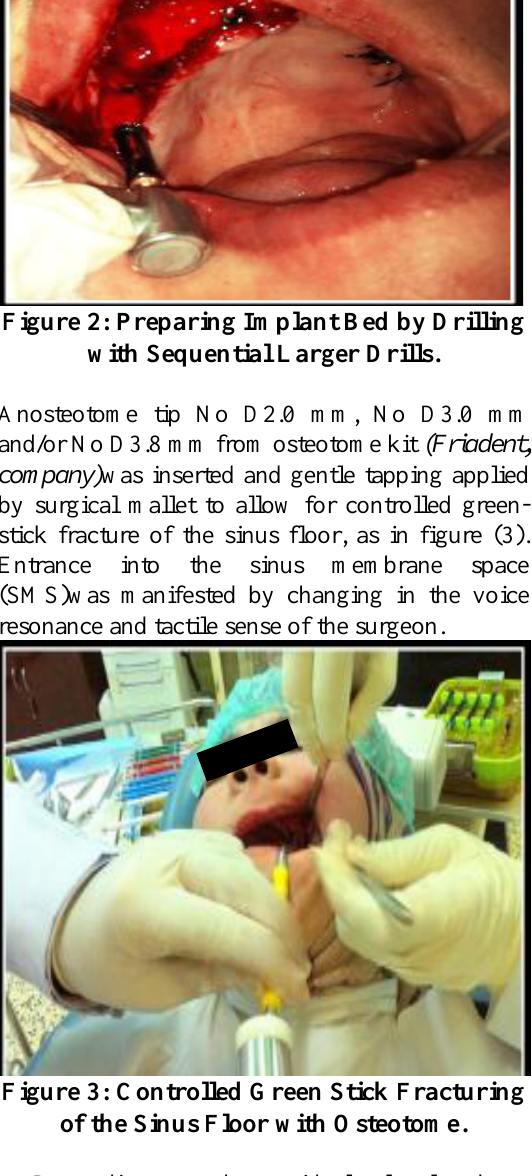
with palatal bias and a full thickness flap